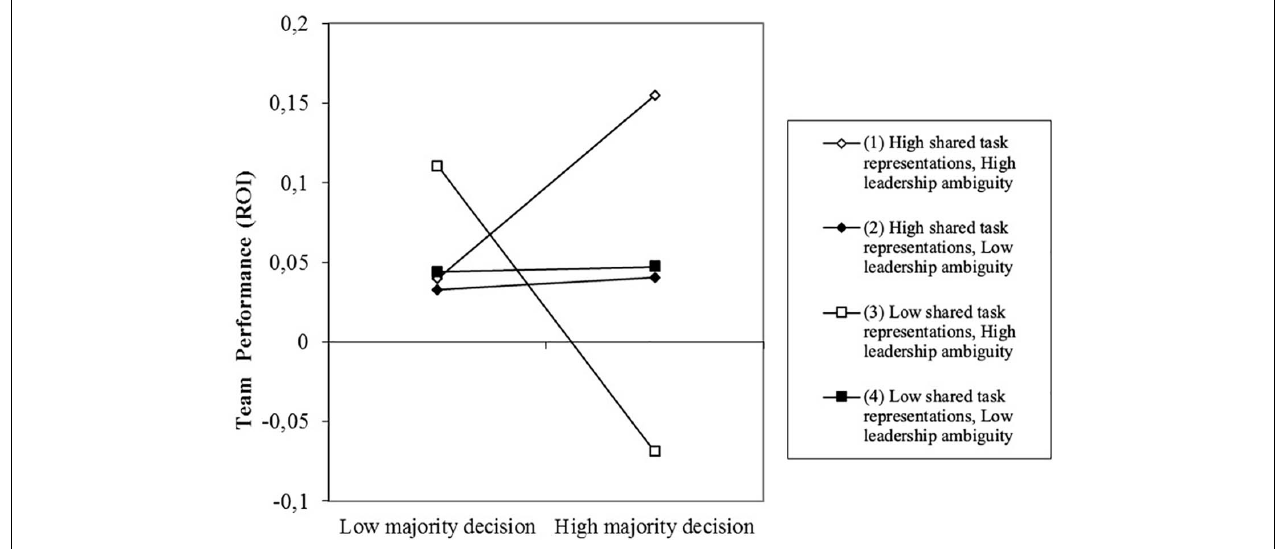
FIGURE 4 | Team performance (ROI) as predicted by majority decision-making, shared task representations and leadership ambiguity.